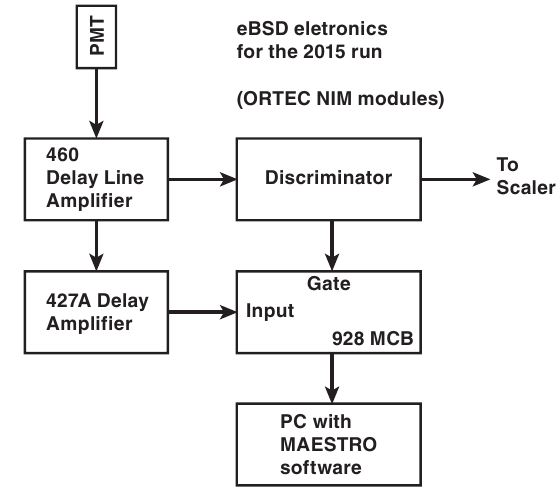
FIG. 13. Schematic of the pulse height analysis system used to optimize the discriminator setting. The multichannel analyzer (MCA) used here consists of an Ortec multichannel buffer (MCB) connected to a computer running the Maestro analysis and control software